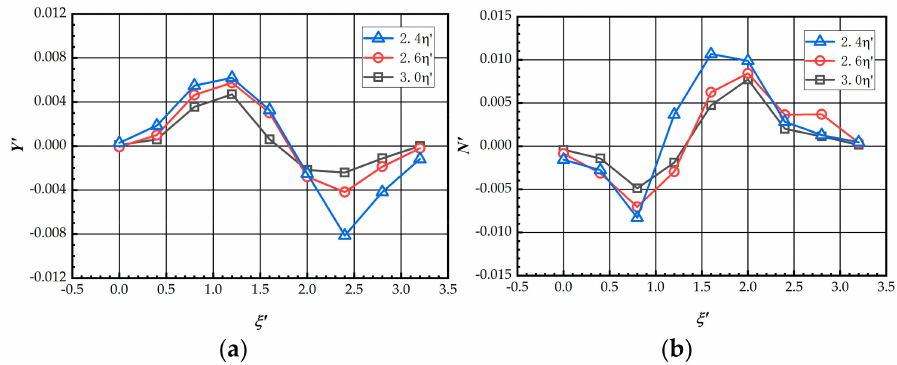
Figure 18. ( a ) The lateral force of DS at different lateral distances; ( b ) The yaw moment of DS at different lateral distances.